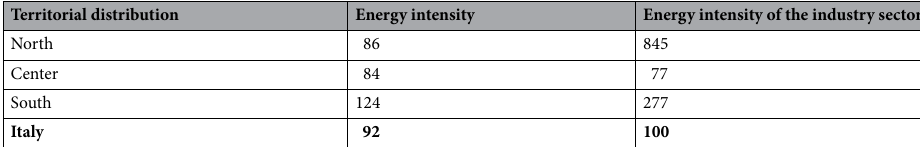
Table 4. M2C3 indicators—Energy efficiency and requalification of buildings by territorial distribution (year 2019). Source : our elaboration on SDGs. National values are in bold.